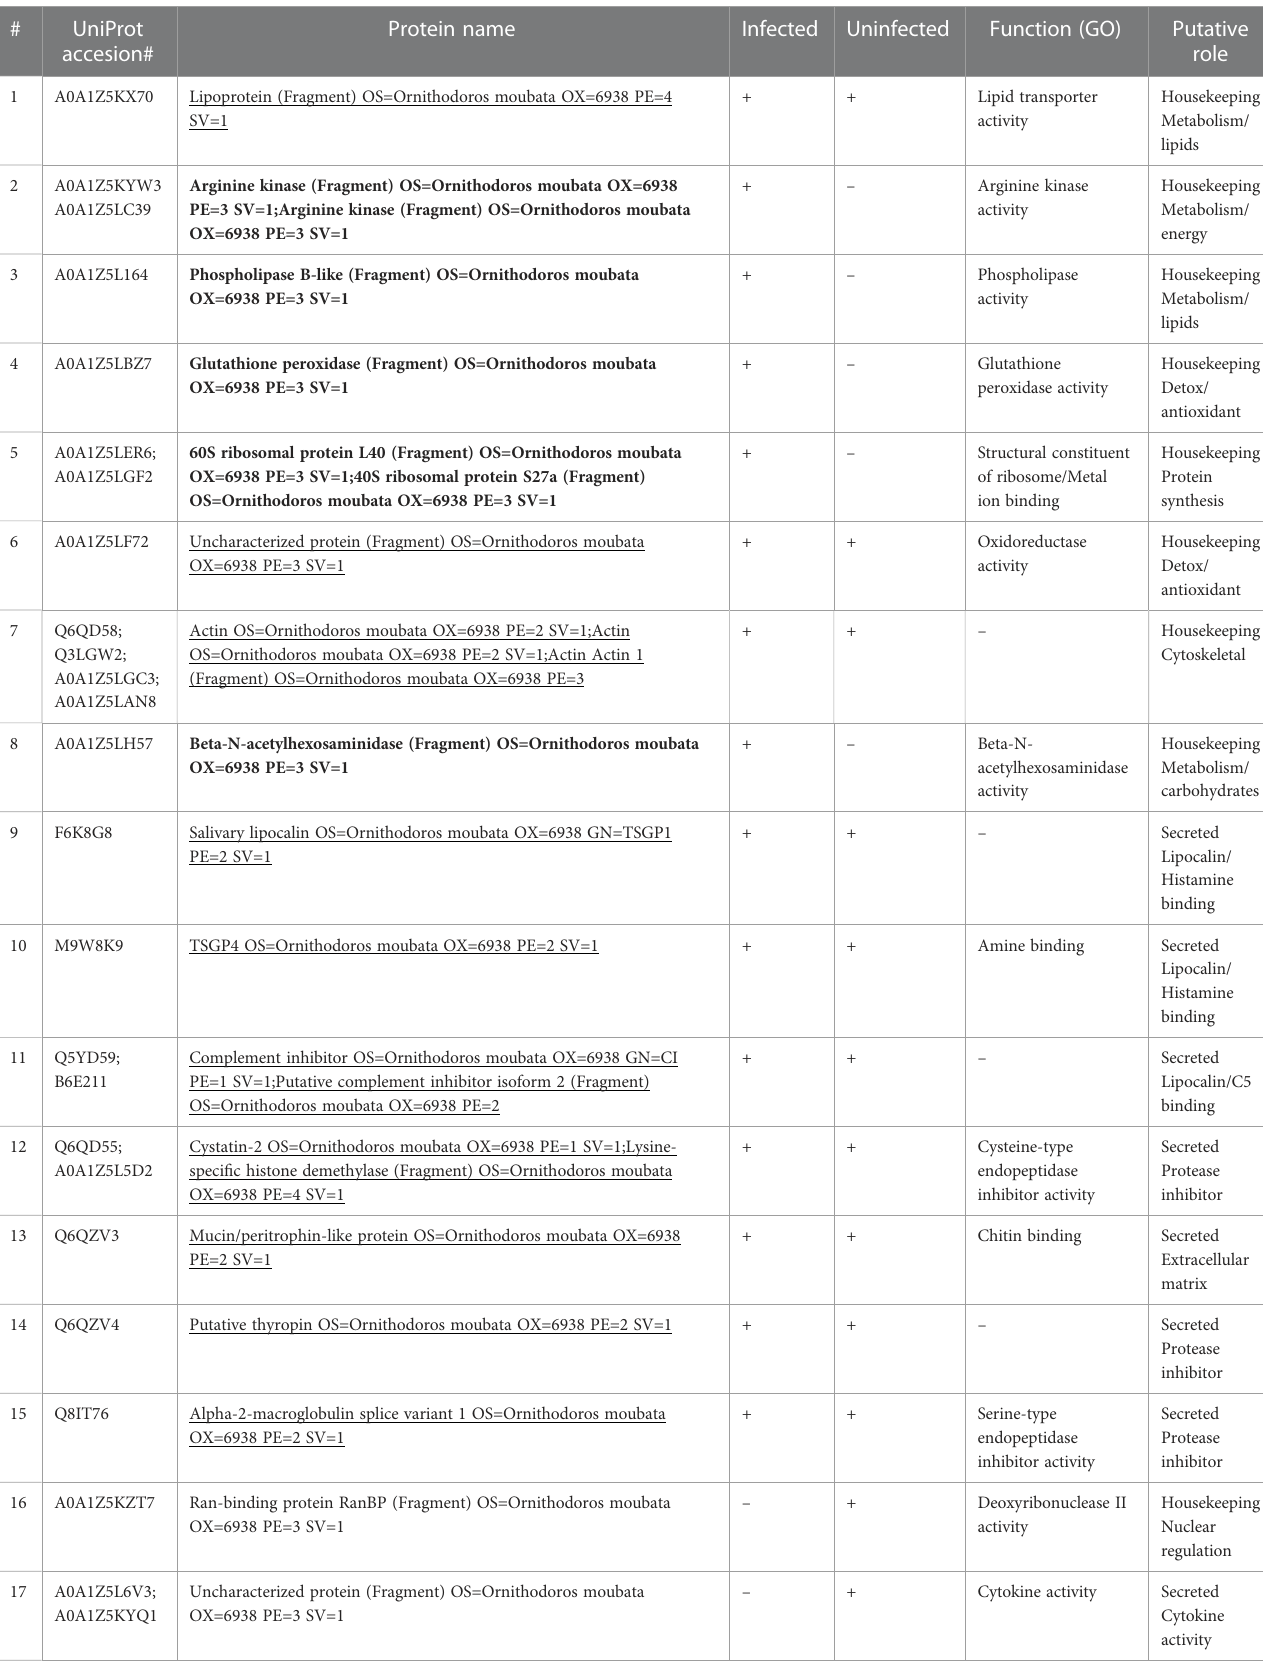
TABLE 2 Proteins identi fi ed in the tick saliva